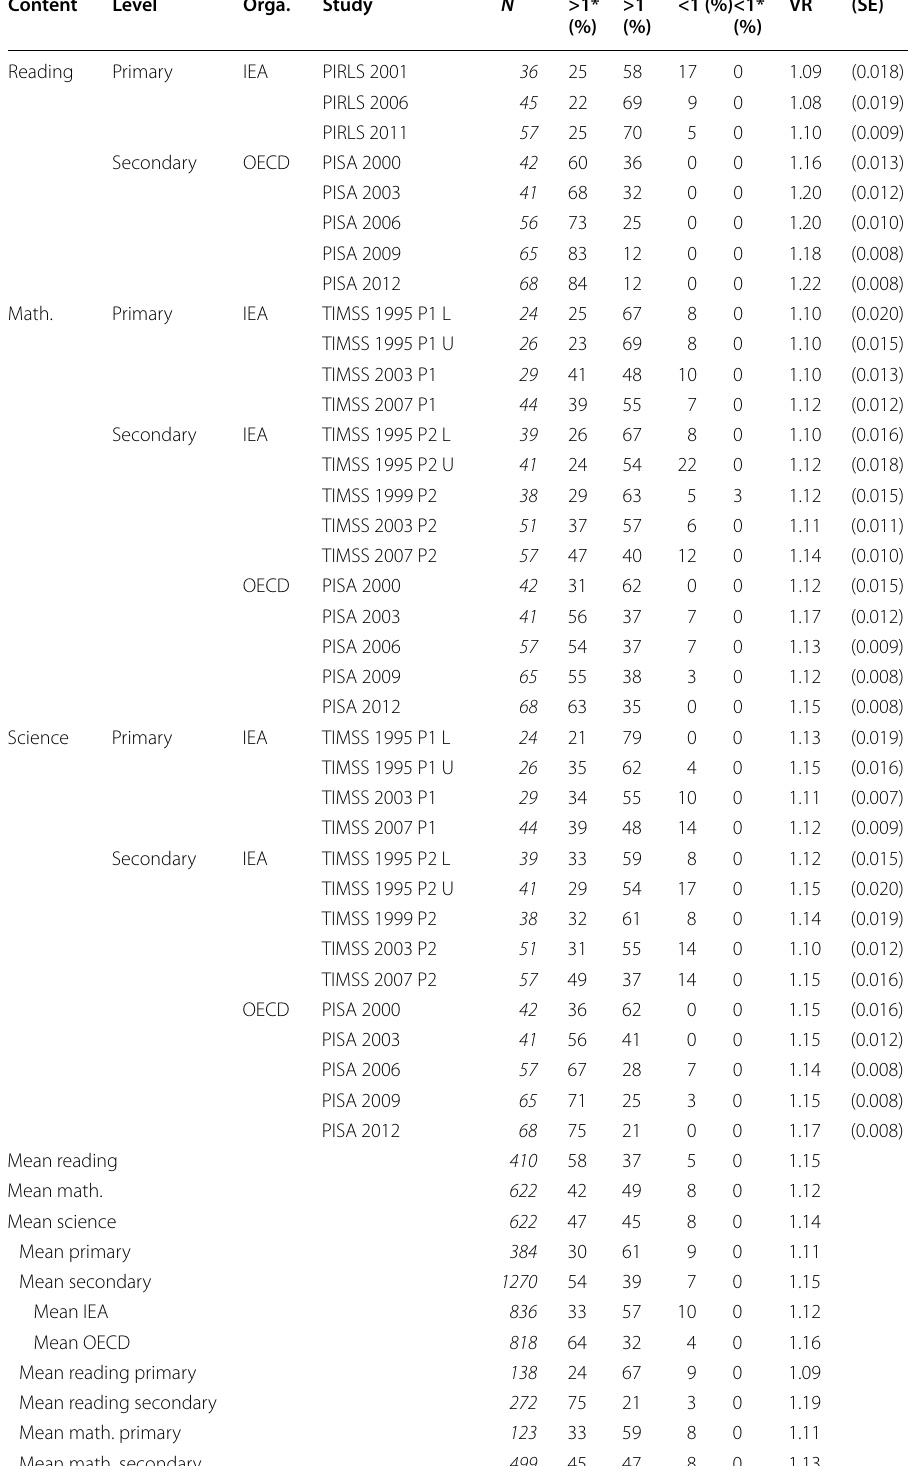
Table 2 Gender differences in variance ratios in reading, mathematics, and science Content